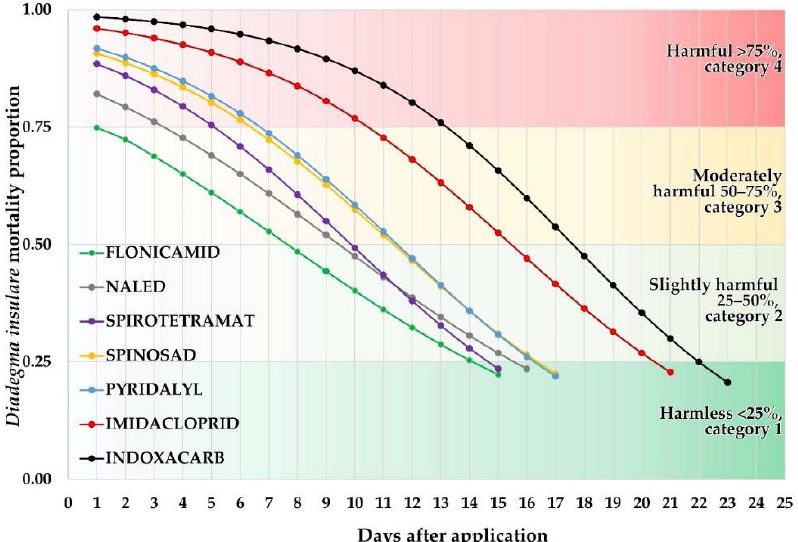
Figure 1. Toxicity and persistence of seven insecticides against adult Diadegma insulare on broccoli